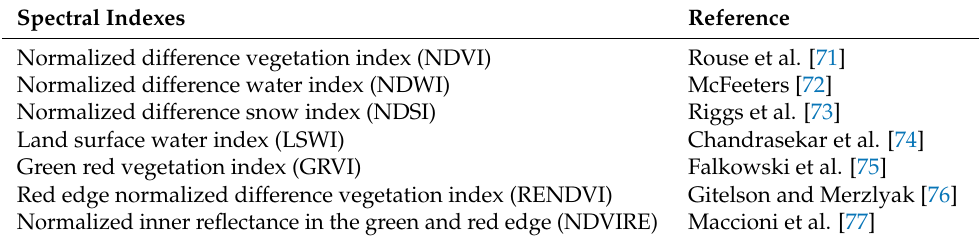
Table 2. List of spectral indexes used in the research. Spectral Indexes Reference Normalized difference vegetation index (NDVI) Normalized difference water index